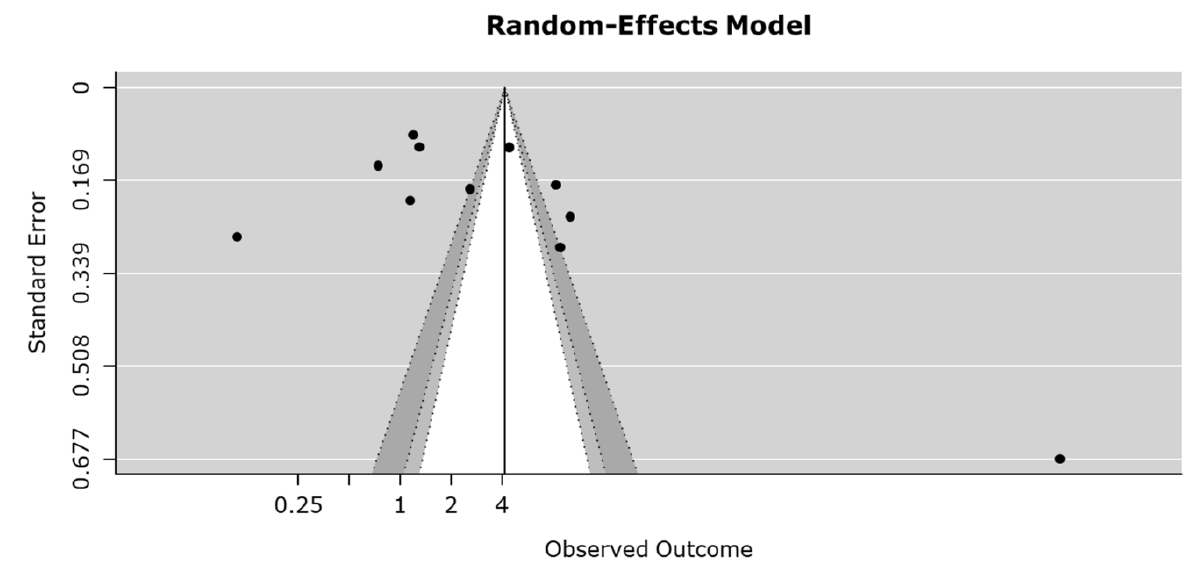
Figure 3. Funnel plot and Egger’s regression test to assess for publication